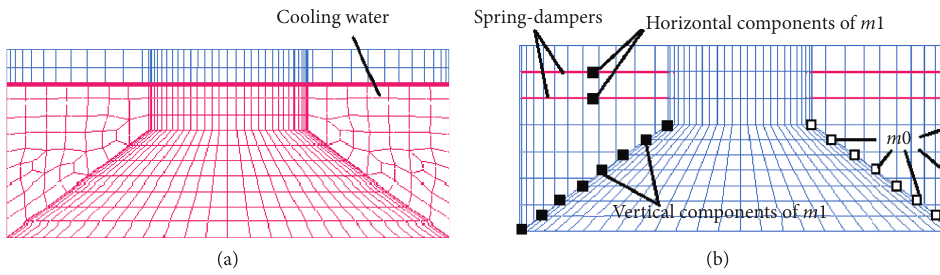
Figure 4: The schematic diagram of simplified model: (a) FSI model and (b) simplified model.